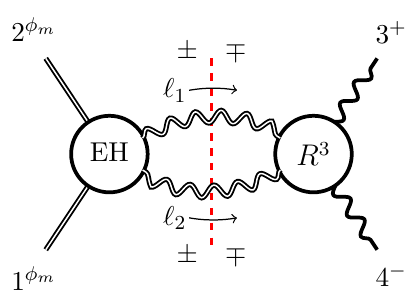
Figure 2 . The cut diagram contributing to the leading R 3 correction to gravitational scattering of a photon (wavy lines) off a massive scalar (double